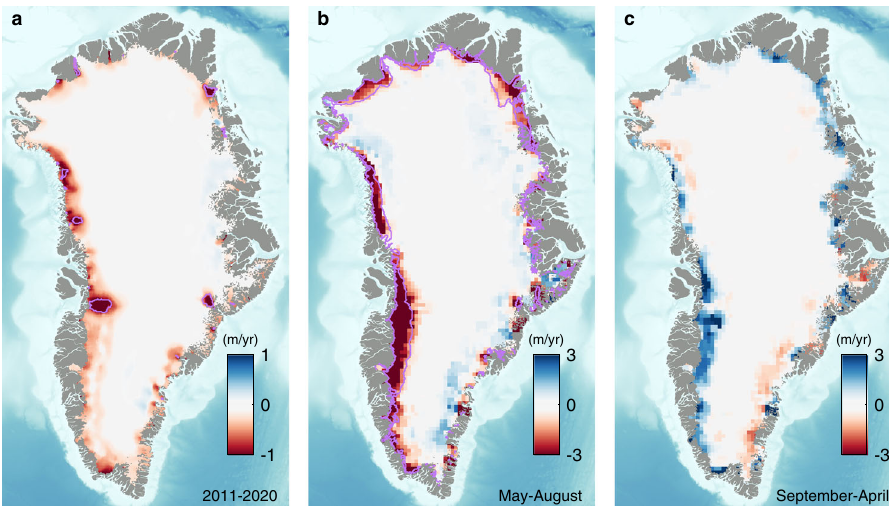
Fig. 1 Greenland Ice Sheet interannual and seasonal elevation change from CryoSat-2 radar altimetry, 2011 – 2020. a Rate of surface elevation change between 2011 and 2020. Purple contours depict areas of long-term dynamical imbalance, from repeat optical imagery 48,49 (1985 – 2018) and dynamic elevation trends determined from satellite altimetry and the Institute for Marine and Atmospheric Research Utrecht Firn Densi fi cation Model (2011 – 2017). b Average rates of elevation change during May – August and between 2011 and 2020. Purple contours depict the extent of the ice sheet ablation zone used in this study. c Average rates of elevation change during September – April between 2011 and 2020.